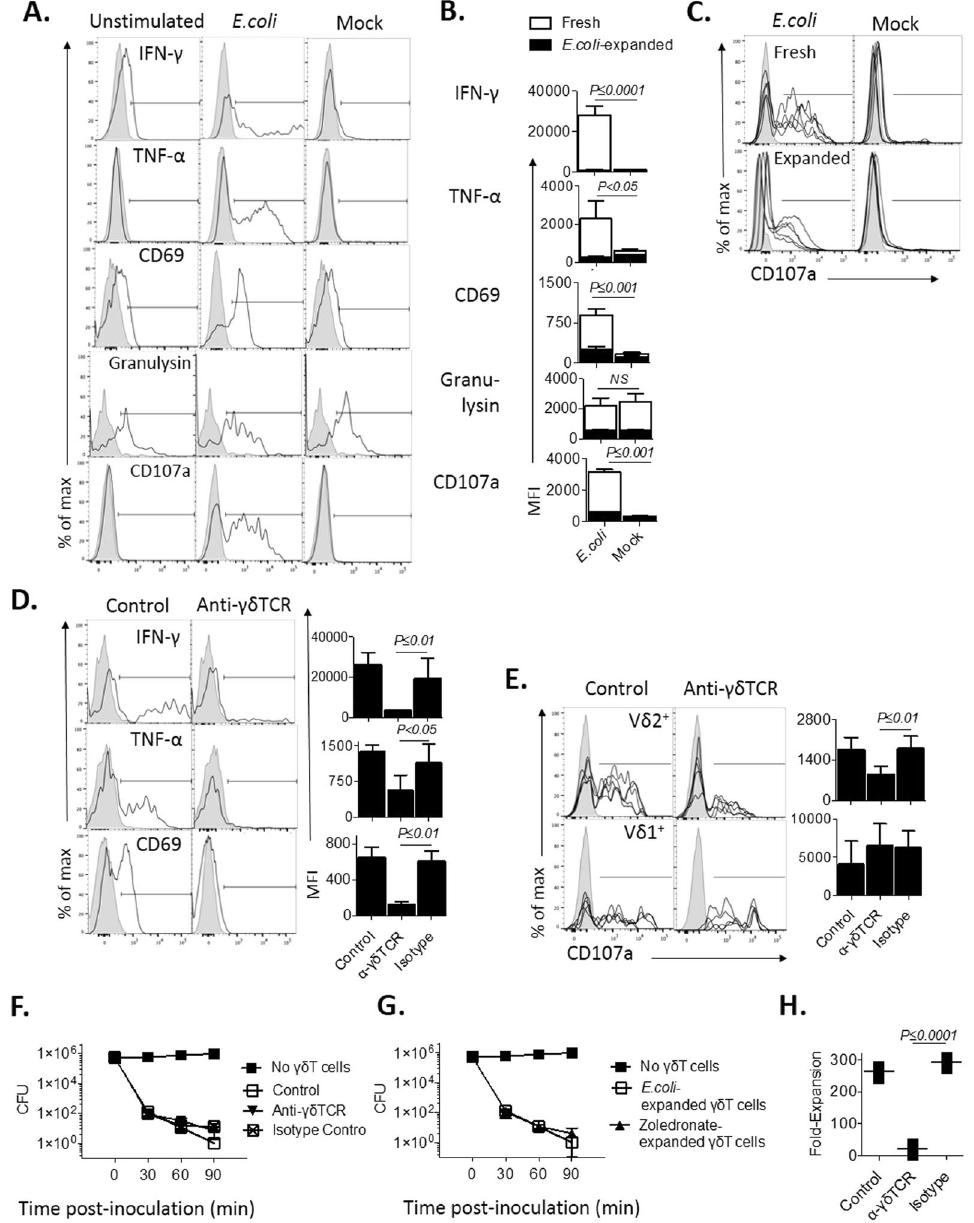
Figure 5. γδ T cell development of a pAPC phenotype is parallel to maintenance of cytotoxicity, but leads to loss of a TCR-dependent Th1 inflammatory phenotype. Freshly-isolated PBMC (n = 5) were stimulated with E. coli and analyzed after overnight (16–18 h) culture or left to expand for 14 days, and re-stimulated with E. coli overnight on day 14. γδ T cell accumulation of intracellular IFN- γ , TNF- α , granulysin, and cell surface CD69 and CD107a were assessed via FACS analysis. ( A ) Freshly-isolated PBMC were analyzed unstimulated, after overnight stimulation with E. coli or IL-2 alone (mock). Representative stains of one donor are shown, gated on γδ T cells, with specific antibody in black, unshaded, and isotype-matched control in gray, shaded. ( B ) Parameter MFI in response to E. coli and mock stimulation were compared between freshly-isolated and 14 day E. coli -expanded γδ T cells. ( C ) Stains of five representative donors are shown for cell surface CD107a in response to E. coli or mock stimulation, comparing fresh and E. coli -expanded γδ T cells. ( D ) Freshly-isolated PBMC were cultured for 2 h with blocking anti- γδ TCR mAb or isotype-matched control. Representative IFN- γ , TNF- α and CD69 staining of one donor, gated on γδ T cells, are shown on the left. A compilation of donor parameter MFI is shown on the right. ( E ) The effect of anti- γδ TCR mAb on fresh γδ T cell surface CD107a is shown for five representative donors, comparing V δ 1 + and V δ 2 + cells. ( F ) E. coli -expanded, FACS-purified γδ T cells were pre-blocked with anti- γδ TCR mAb, isotype control or normal media (control) prior to co-culture with live E. coli . At designated time points the co-culture was lysed in H 2 O, and plated on agar for overnight growth; resulting E. coli CFU were counted. ( G ) E. coli and zoledronate-expanded, FACS-purified γδ T cells were co-cultured with live E. coli . Remaining E. coli CFU were counted. ( H ) Proliferation in response to E. coli stimulation was observed in γδ T cells pre-blocked with anti- γδ TCR